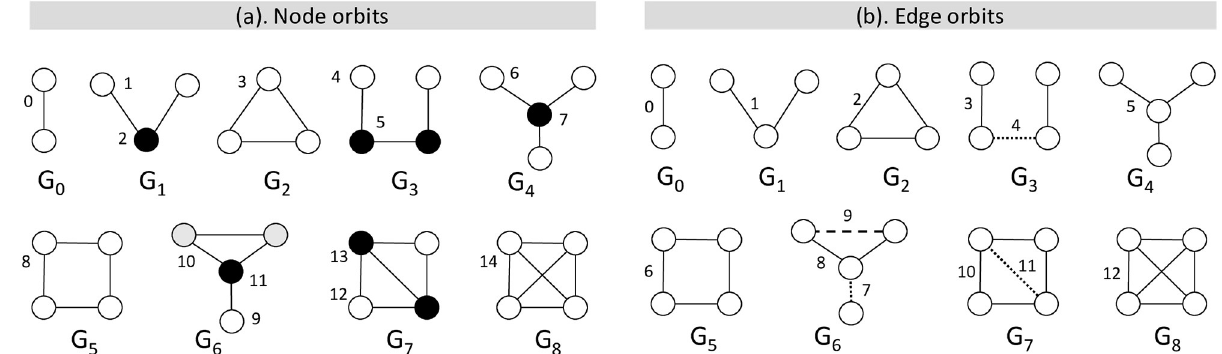
Fig 1. Graphlets of 2–4 nodes with the enumeration of orbits. (a) Node orbits: there are in total 15 node orbits, different node colors indicating nonisomorphic node positions within a given graphlet. (b) Edge orbits: there are in total 13 edge orbits, different line types denoting nonisomorphic edge positions within a given